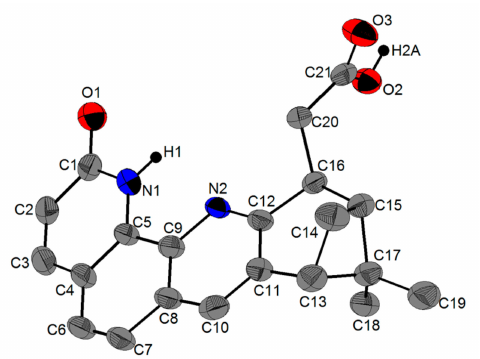
Figure 5. View of the molecular structure of 6 as determined by single crystal X-ray di ff raction, at 30% probability. The H atoms connected to carbon atoms have been removed for